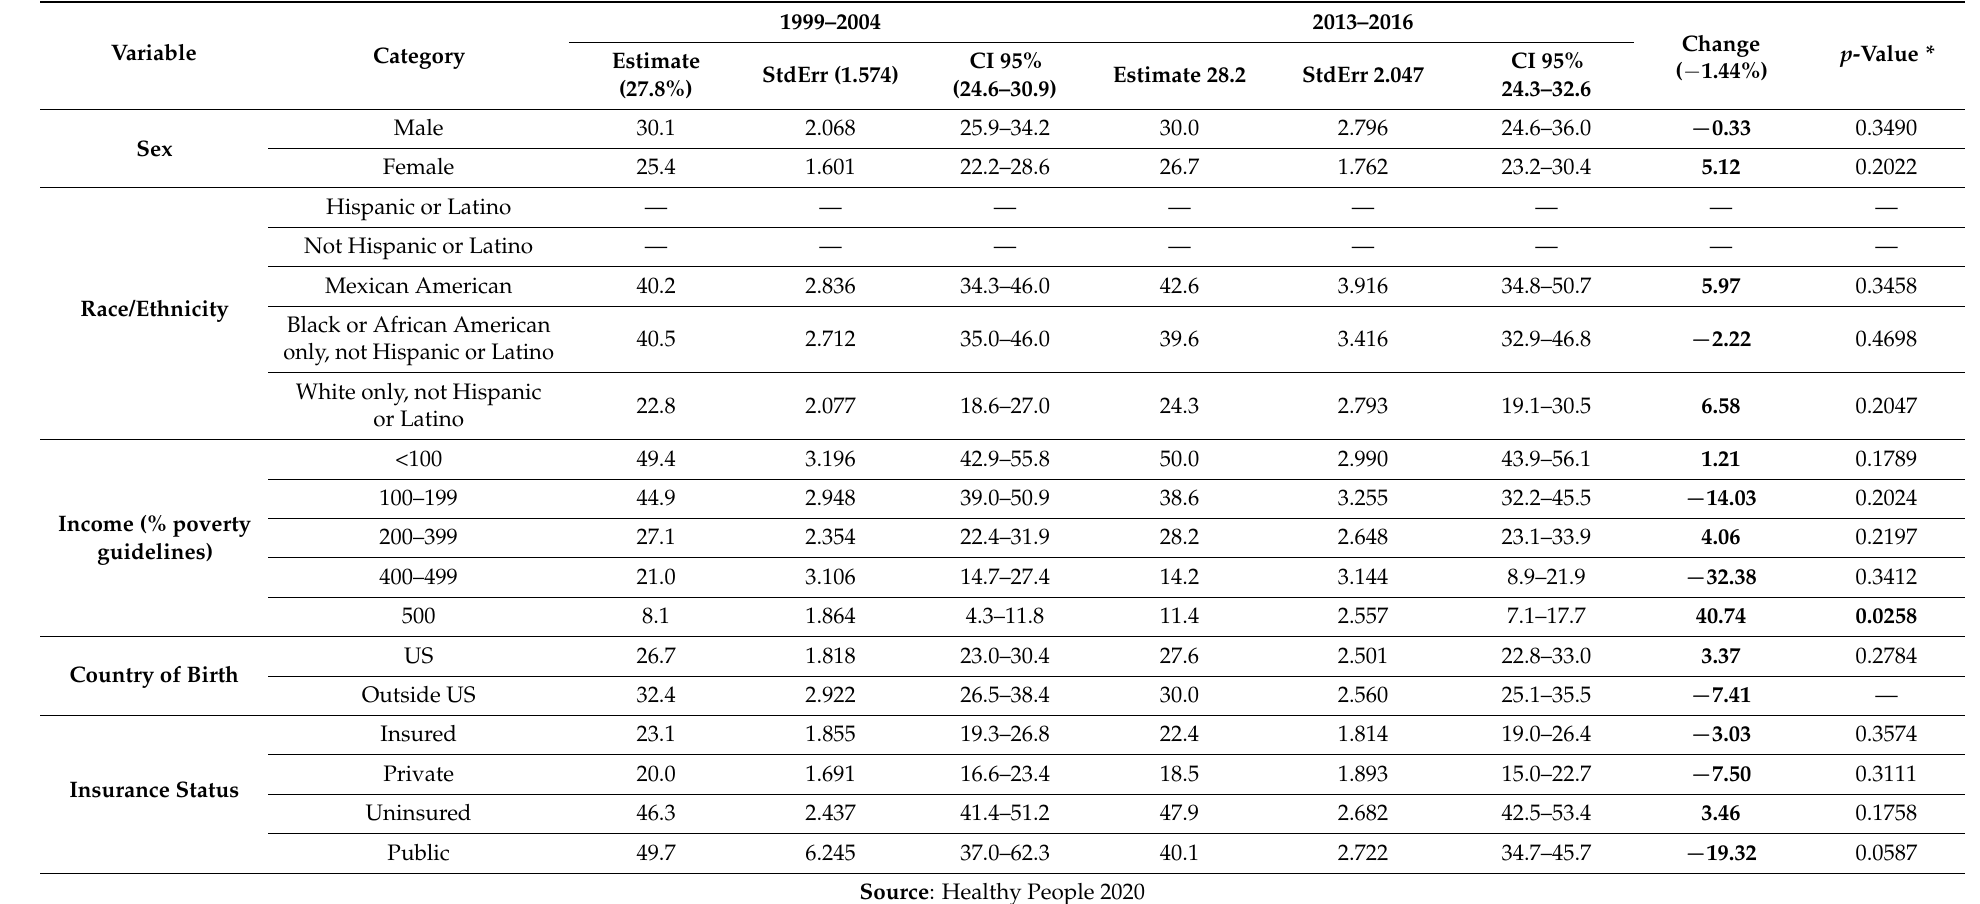
Table 5. Distribution of OH 3.1: decay 35–44 years, according to sociodemographic characteristics. Healthy People 2020. USA,